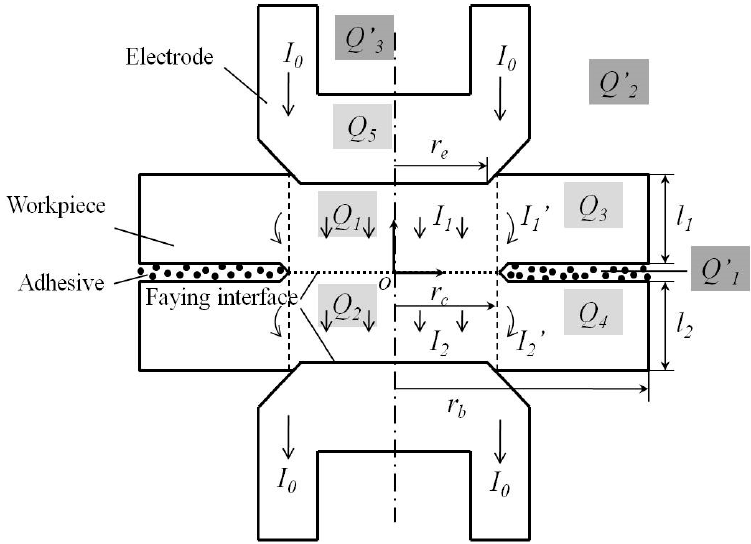
Figure 2. Heat generation and loss during the weld cycle in weld-bonding.